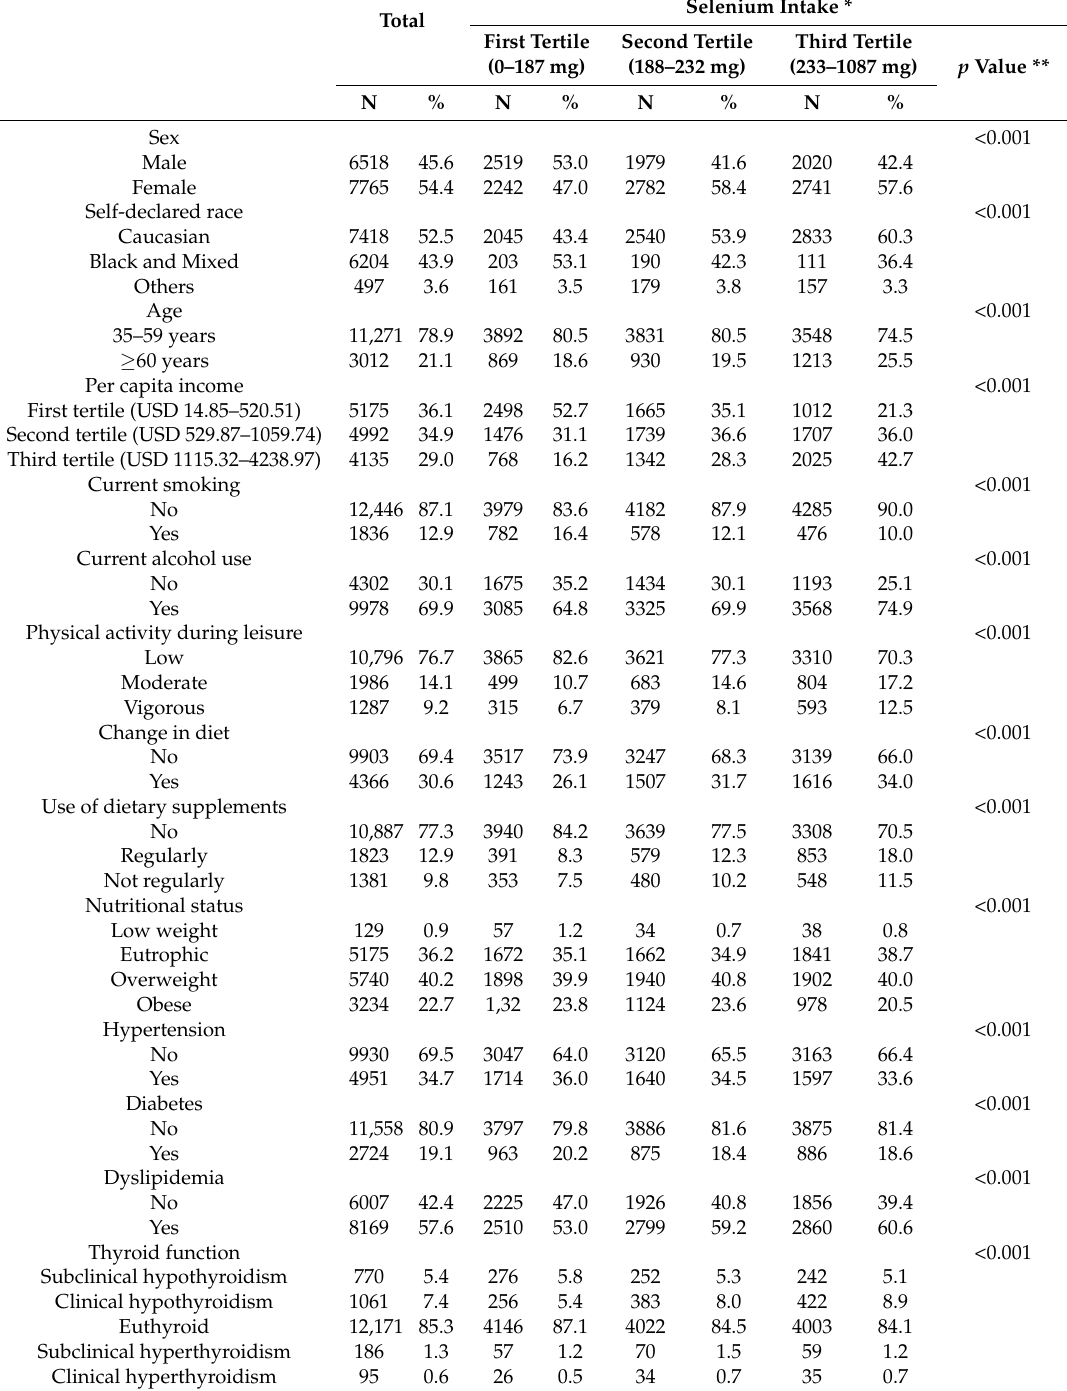
Table 1. Description of the total population and selenium consumption per tertile in the ELSA-Brasil study,